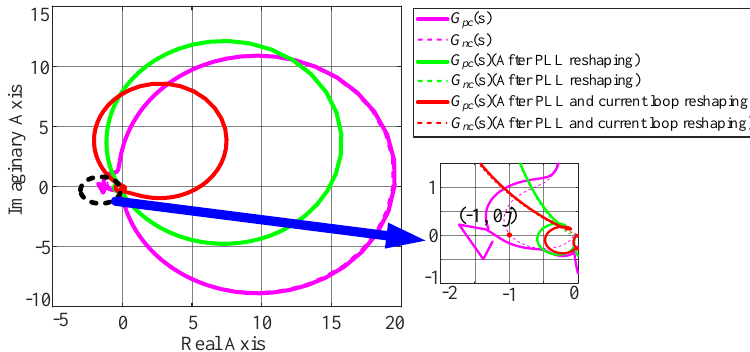
Figure 11. Nyquist Plots of (25) after adding the impedance reshaping.